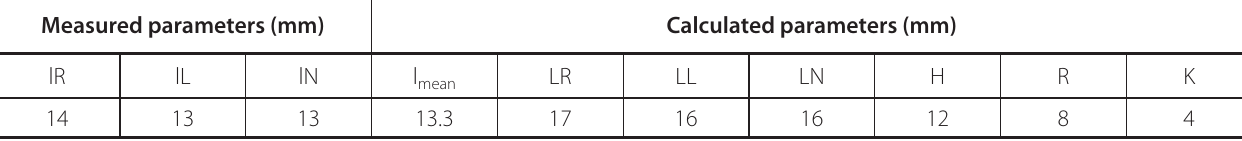
Fig. 1 - Sizing of the intercommissural distances of right, left and noncoronary cusps. Table 1 . Measured and calculated parameters of aortic root and valve cusps.